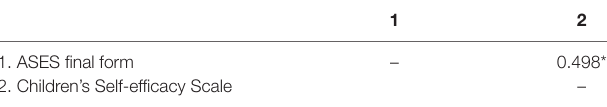
TaBle 2 | Convergent Validity correlation between Academic Self-efficacy Scale (ASES) Final Form and